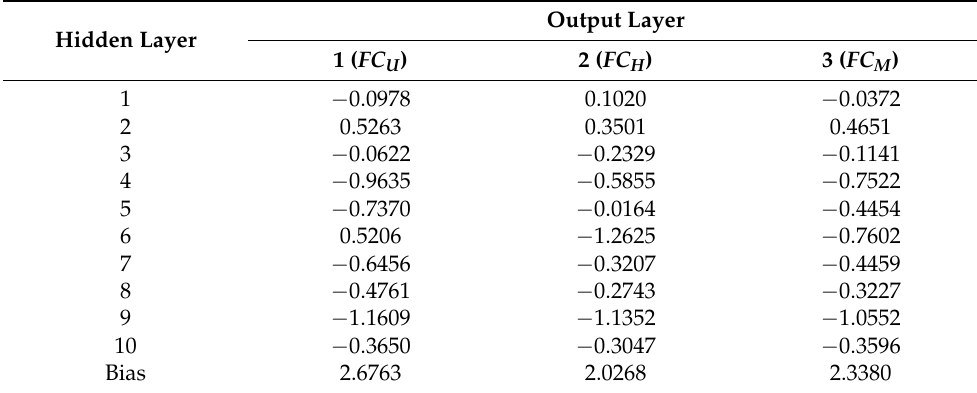
Table A4. Weights between the hidden layer and the output layer in the MLP 22-10-3 artificial neural